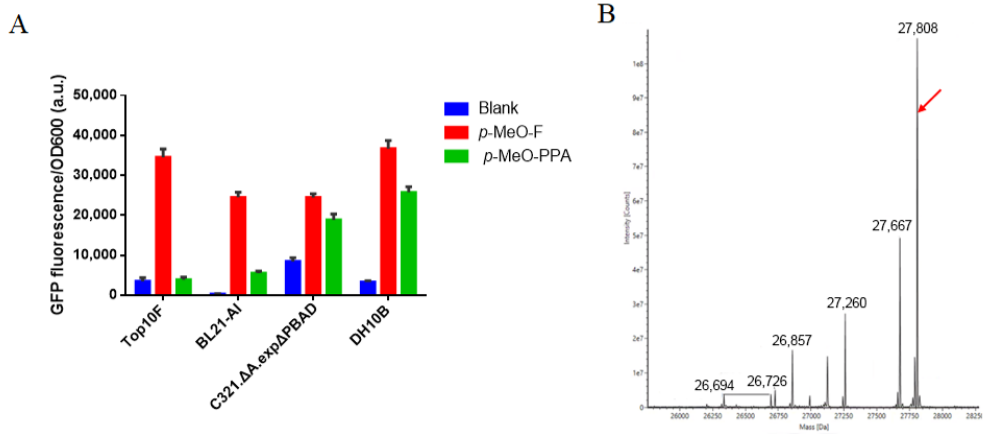
Figure 2. Comparison of the eGFP fluorescence of different E. coli strains supplemented with p - MeO-F or p -MeO-PPA. ( A ). The measured total eGFP fluorescence intensity is the result of the biotransformation of the supplemented keto acids. In vivo amber suppression activity is enabled in strains contain plasmids pBAD-eGFP(149TAG) and pEvolve-MmRS/tRNA CUA , using absence of p -MeO-PPA. ( B ). Electrospray ionization mass spectrometry of purified eGFP obtained from E. coli cultured in presence of p -MeO-PPA confirmed the incorporation of p -MeO-F. The error bars show the mean and SEM of three independent